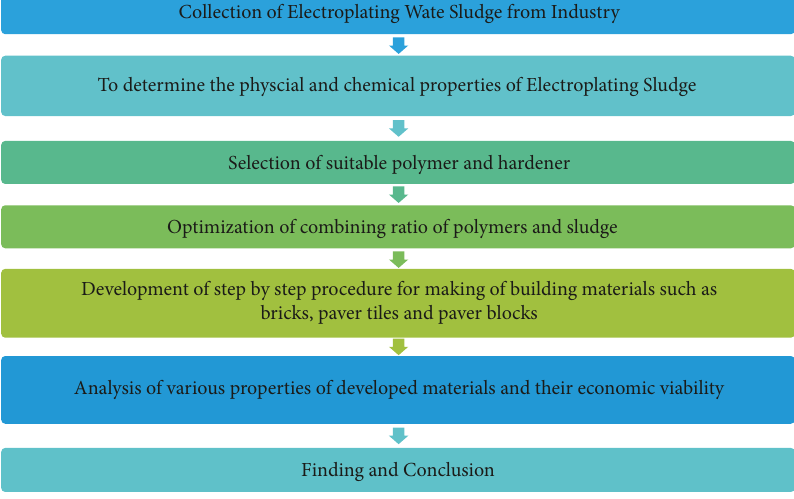
Figure 3: Development approach of paver blocks, tiles, and bricks. Table 5: Tests on polyurethane resin and hardener. S. No